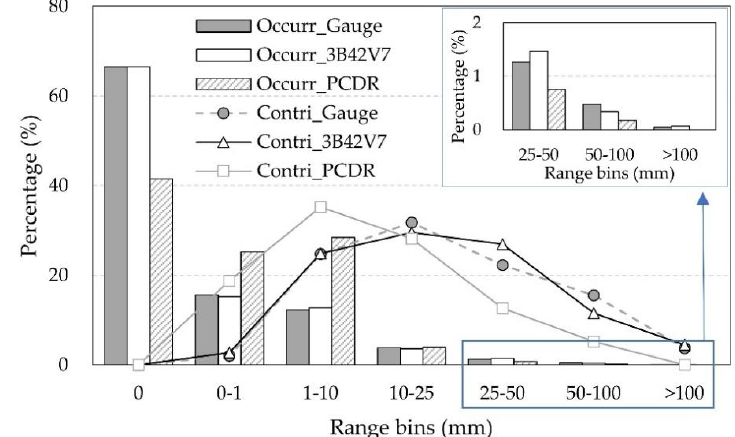
Figure 4. Distribution of daily precipitation for different precipitation classes (“Occurr” in histogram), and their contribution to the total precipitation (“Contri” in line) during the period 2000–2015.